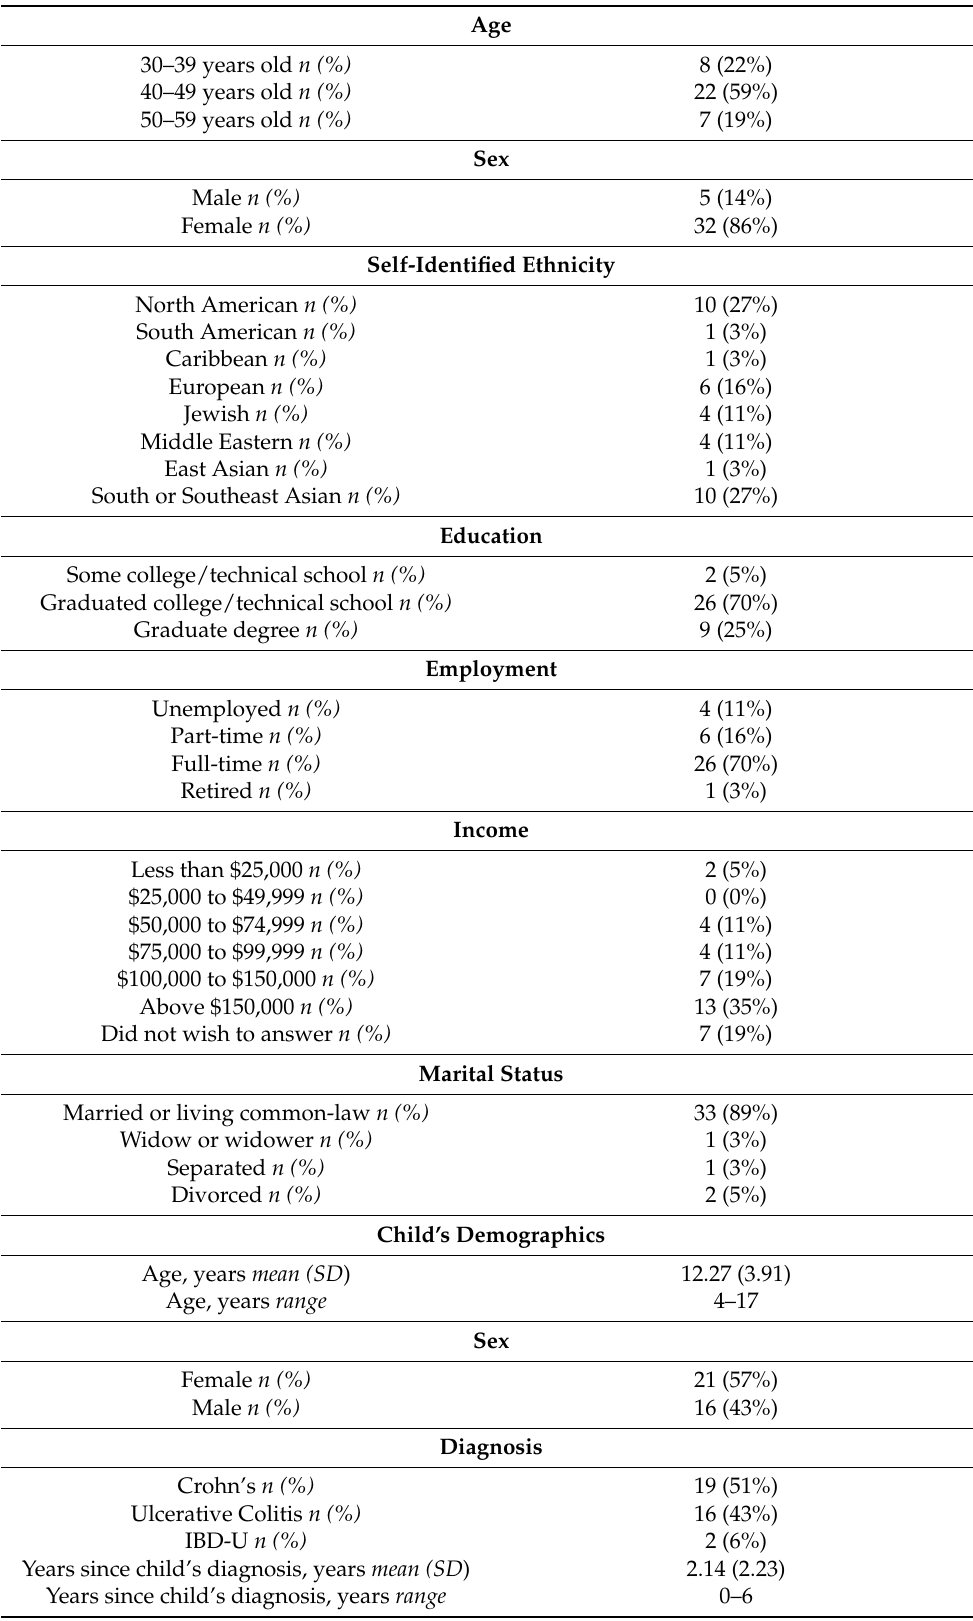
Table 3. Parent Demographics ( n =